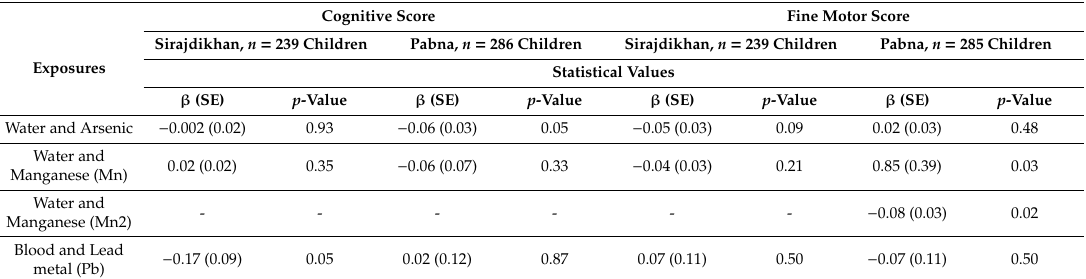
Table 1. Models of metals exposure and BSID-III scores regarding cognitive and fine motor activities collected from children living in Sirajdikhan and Pabna, Bangladesh, adapted after [24]. Cognitive Score Fine Motor Exposures